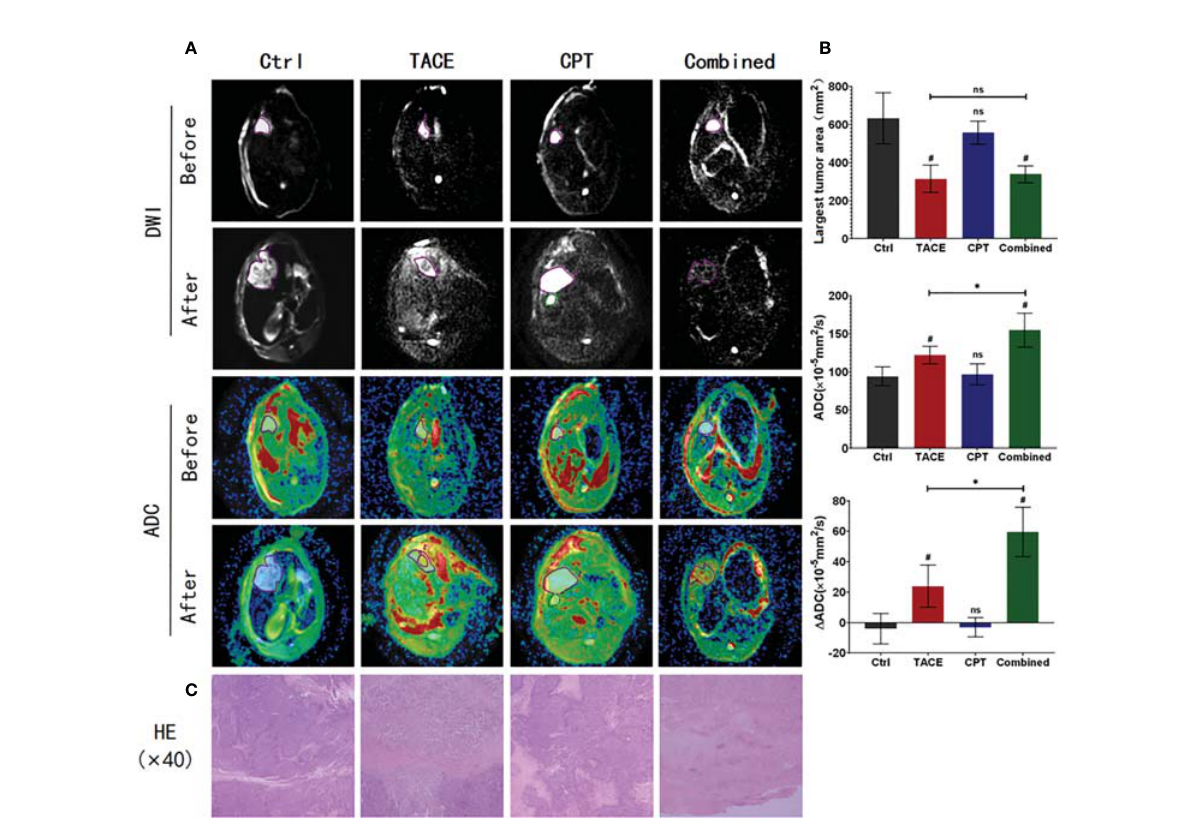
FIGURE 4 Post-processing and data statistics of magnetic resonance imaging, diffusion-weighted imaging (DWI), and apparent diffusion coef fi cient (ADC) sequences; high signal DWI, corresponding to low signal ADC, indicates a tumor tissue with restricted diffusion; higher ADC signal indicates lower tumor activity; further observation of tumor necrosis by H&E staining. (A) In the after image, the Combined group had more complete low activity tumor areas; areas of hyperactive tumor remained in the TACE group. Diffusion images affected by death in the Ctrl group are shown, and ADC values for this data are not included in the statistics. (B) The Combined and TACE groups have smaller maximum tumor areas. The Combined group has lower tumor activity and bigger D ADC. (C) The Combined group had more complete tumor necrosis, whereas the TACE group still had tumor tissue residual at the necrotic margin. * P < 0.05, # P < 0.05, ns P >